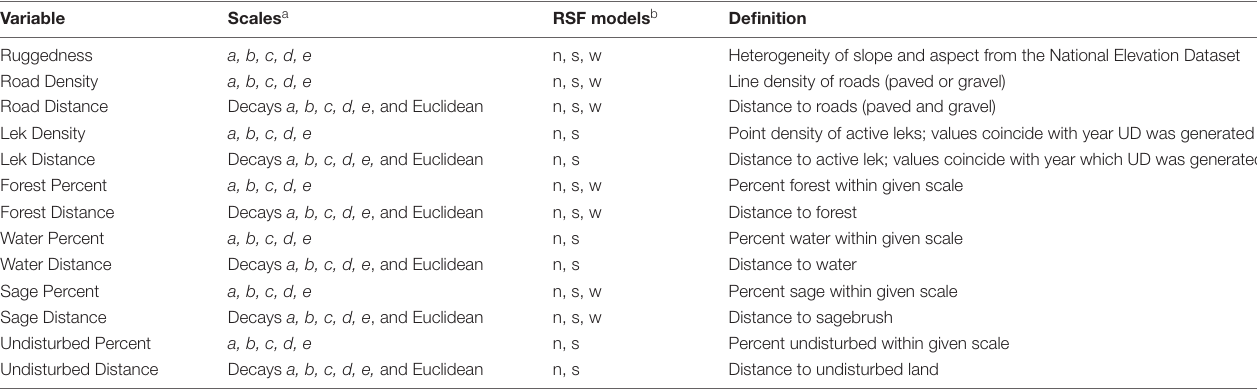
TABLE 1 | Variables considered for use in all resource selection function (RSF) model types (nest-site, spring/summer, winter).